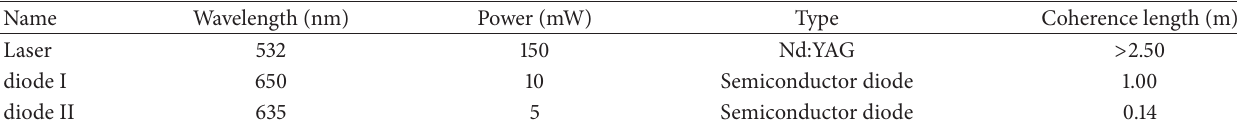
Table 1: Technical specification of tested light sources.